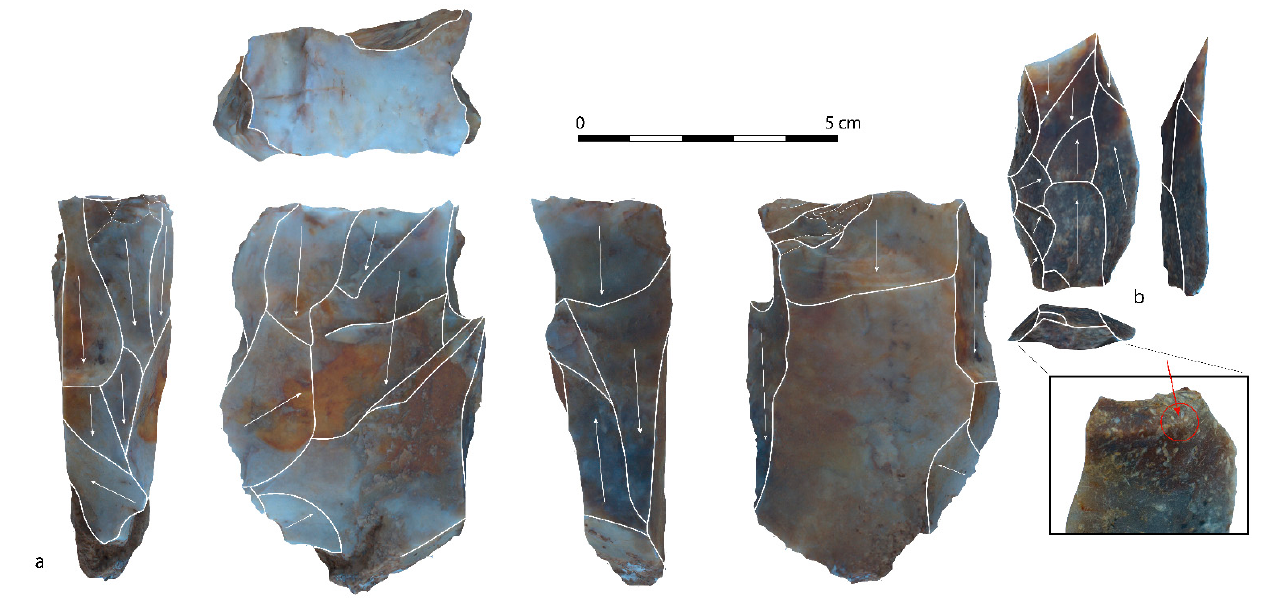
Figure 8. Lojanik 2, lithic artefacts found in 2022: ( a ) narrow-faced blade core; ( b ) blade.